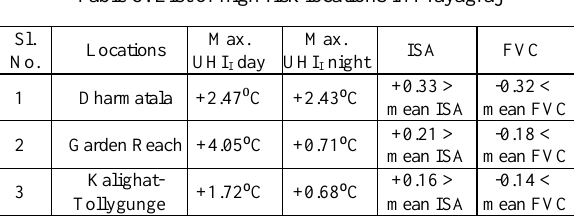
Table 5. List of high risk locations in Prayagraj